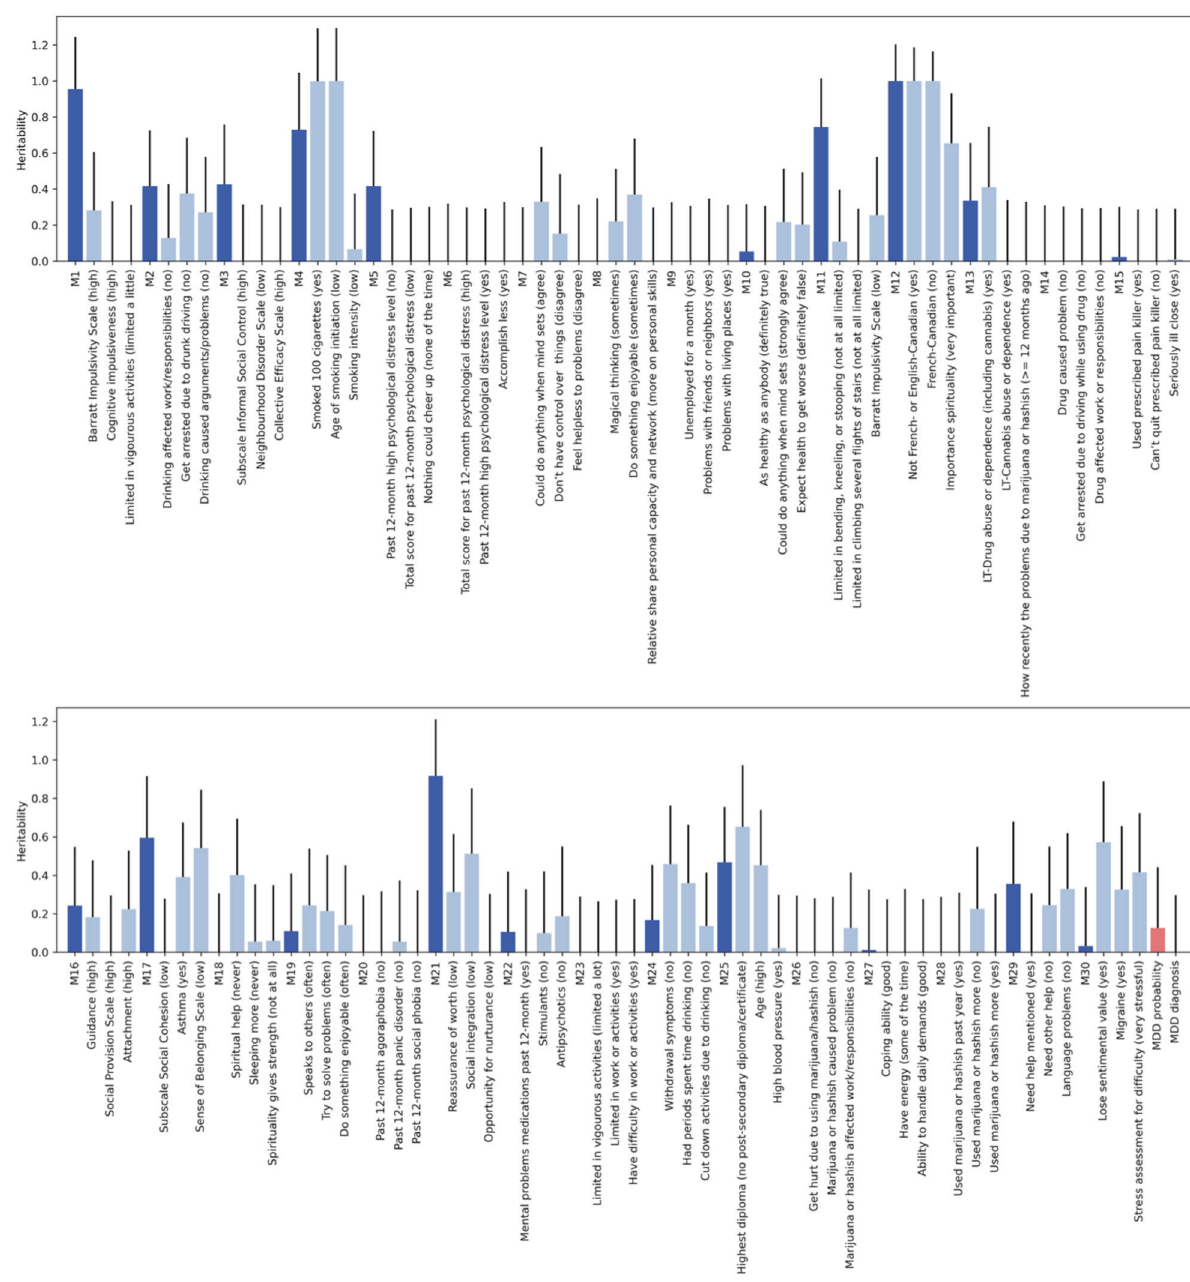
Fig. 4 SNP-heritability for 30 meta-phenotypes and top three predictors for each basic cellular functioning, immune, the development of cancer, neurological and developmental functioning. For instance, the high psychological distress (M6) subgroup identi fi ed top pathways involved in the occurrence of psychiatric disorders, including MDD, as well as a pharmacogenomics-based pathway, that is involved in pharmacokinetic and pharmacodynamic processes [44]. Comorbid MDD and substance use subgroup (M13) identi fi ed more essential pathways related to synapse formation, for instance, chemical-synaptic-transmission, and synaptic signaling. Synapse formation plays an important role in neurocircuitry and likely requires interactions between pre-and post-synaptic neu- rons [45]. The use of antidepressants subgroup (M22) found the top signi fi cant pathways related to psychiatric disorders, immune functioning, and depression. The better self-rated health subgroup